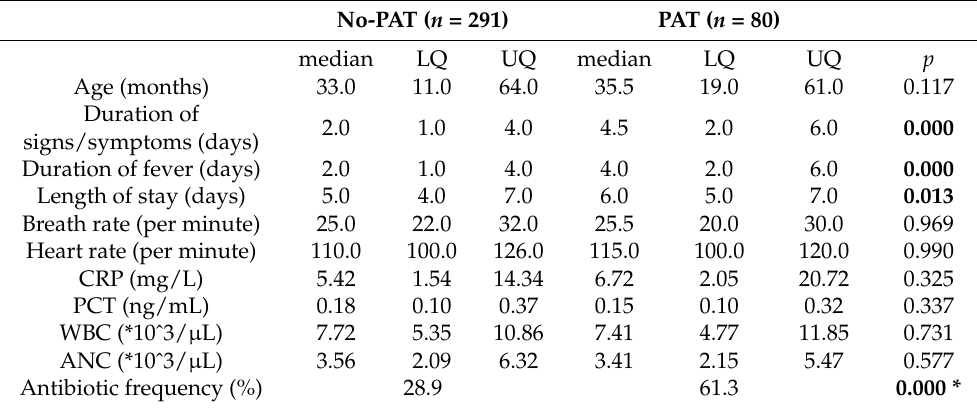
Table 1. Baseline characteristic in the group with and without previous antibacterial therapy (PAT and No-PAT group). Abbreviations: LQ—lower quartile, UQ—upper quartile, CRP—C-reactive protein, PCT—procalcitonin, WBC—white blood cells, ANC—absolute neutrophil count. * Fisher’s exact test.